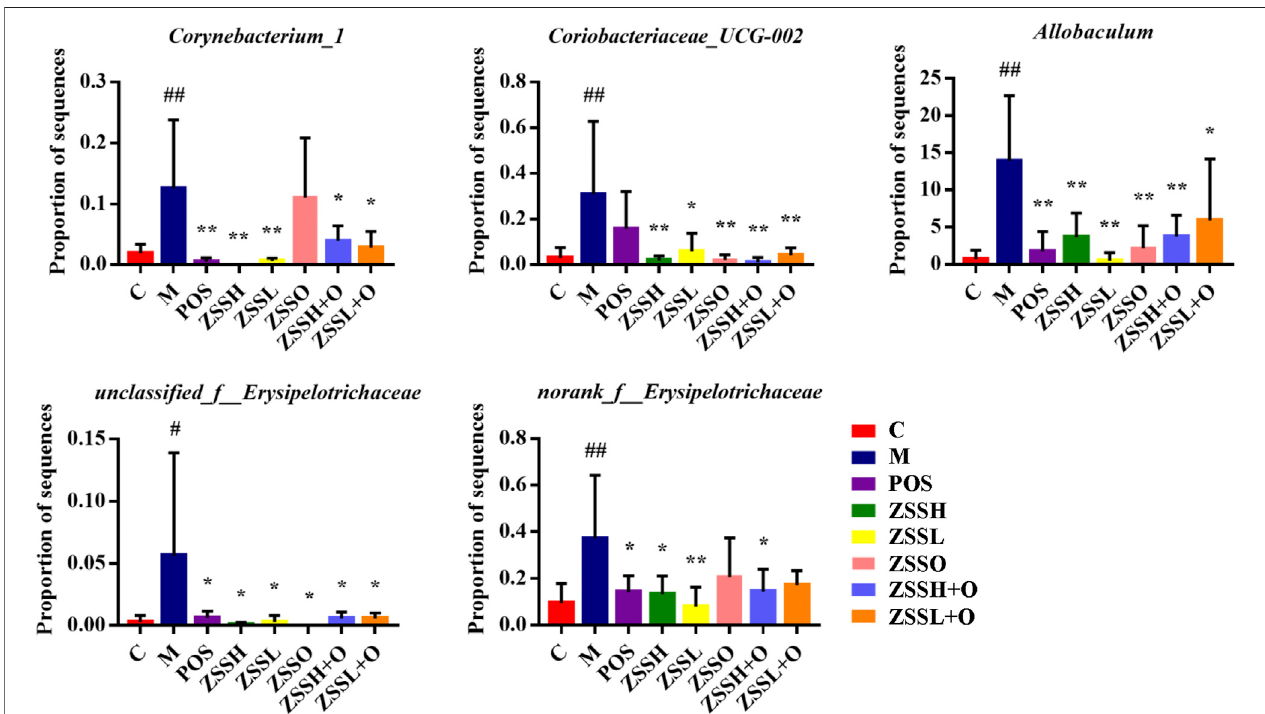
FIGURE 6| Average relative abundance of different genera ofintestinal fl ora in each group. (C) control group; (M) model group; (POS) positive group; (ZSSH) high- dose ZSS ethanol extract group; (ZSSL) low-dose ZSS ethanol extract group; (ZSSO) ZSS oil extract group; (ZSSH + O) high-dose ZSS ethanol + oil extract group; (ZSSL + O) low-dose ZSS ethanol + oil extract group. Values are presented as the mean ± SD, n (cid:2) 6. # p < 0.05, ## p < 0.01: model vs control; * p < 0.05, ** p < 0.01: treatment vs model.